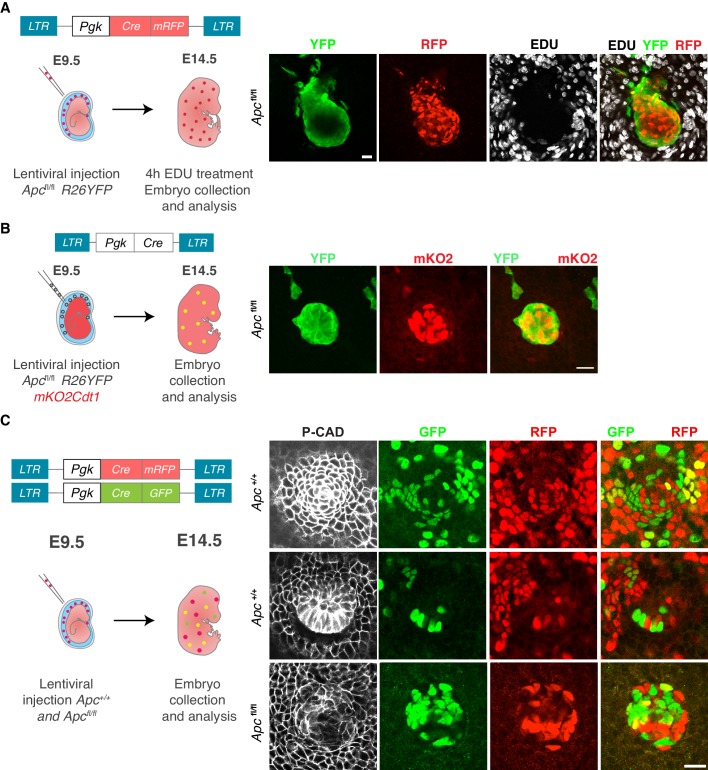
Apc-null cells aggregate into clusters and are non-proliferative.(A) Experimental design and proliferation analysis. Apcfl/fl; Rosa26-lox-stop-lox-YFP embryos were transduced at E9.5 with LVs harboring a Cre recombinase (Pgk-Cre-mRFP) and analyzed at E14.5. At 4 hr prior to analysis, a pulse of 5-Ethynyl-2'-deoxyuridine (EdU) was administered. Note the absence of EDU-positive cells within the clusters. Scale bar, 10 μm. (B) Apcfl/fl YFPfl/fl mKO2Cdt1 embryos were transduced with Pgk-Cre as shown in the schematic. Representative image of an Apc-null cluster is shown at right. Note that YFP+ cells are simultaneously positive for the G0/G1 sensor mKO2Cdt1, in agreement with the non-proliferative status of these clusters. Scale bar, 20 μm. (C) E9.5 Apcfl/fl embryos were transduced with LVs harboring different fluorescing Cre recombinases and analyzed 5d later. Note that like placodes, clusters are multiclonal, reflected by the presence of both RFP and GFP tagged cells. Scale bars, 20 μm.